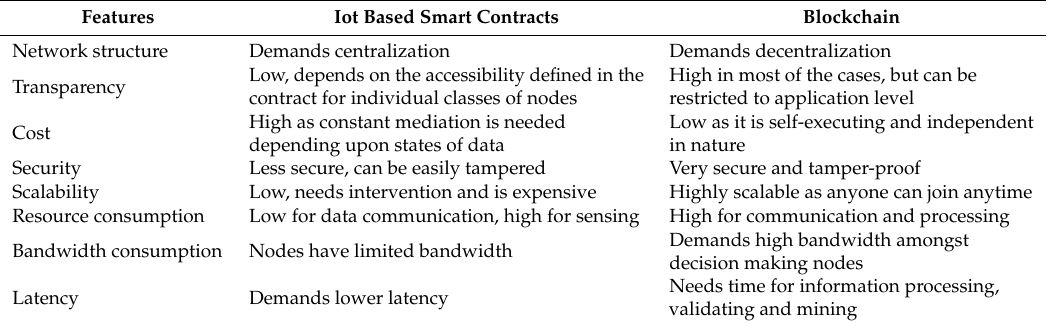
Table 1. Comparison between Blockchain and Internet of Things (IoT) demands with respect to certain features.